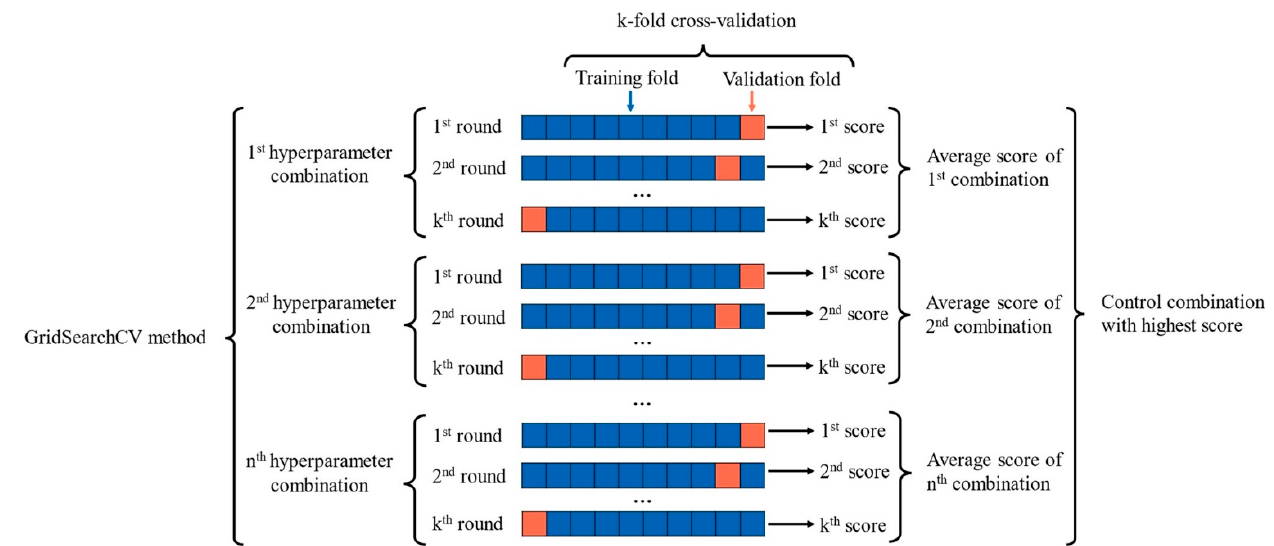
Figure 4. Hyperparameter tuning using five-fold cross validation (GridSearchCV).